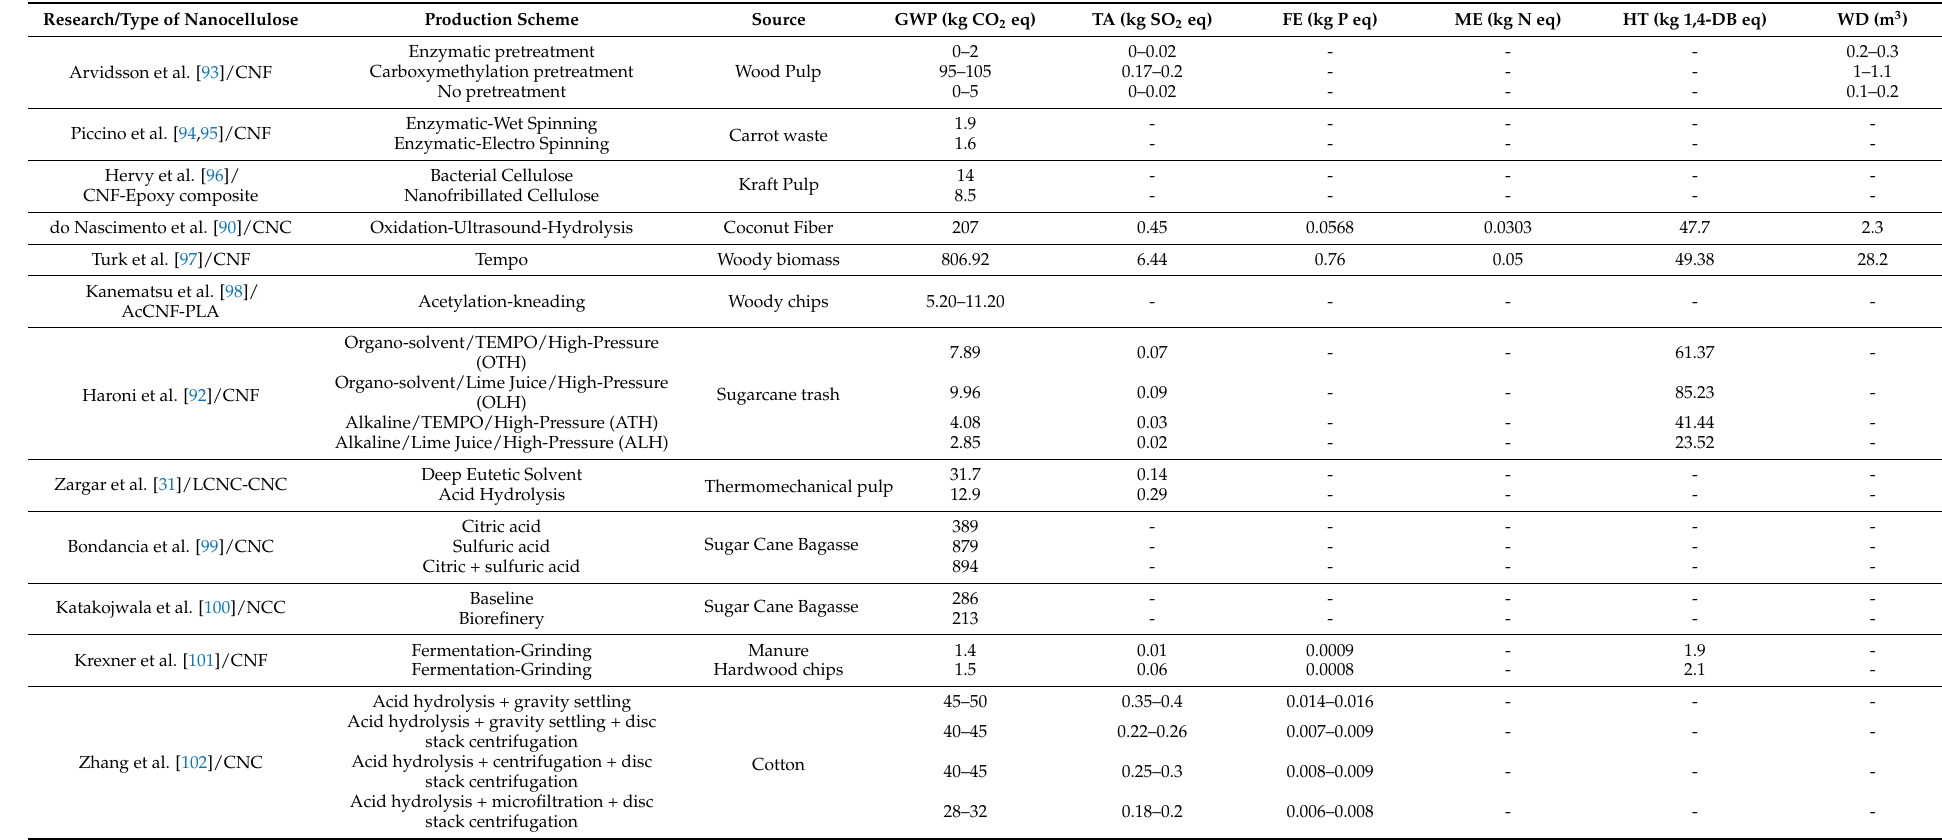
Table 3. Literature review for the Life Cycle Assessment of the production of nanocellulose and its